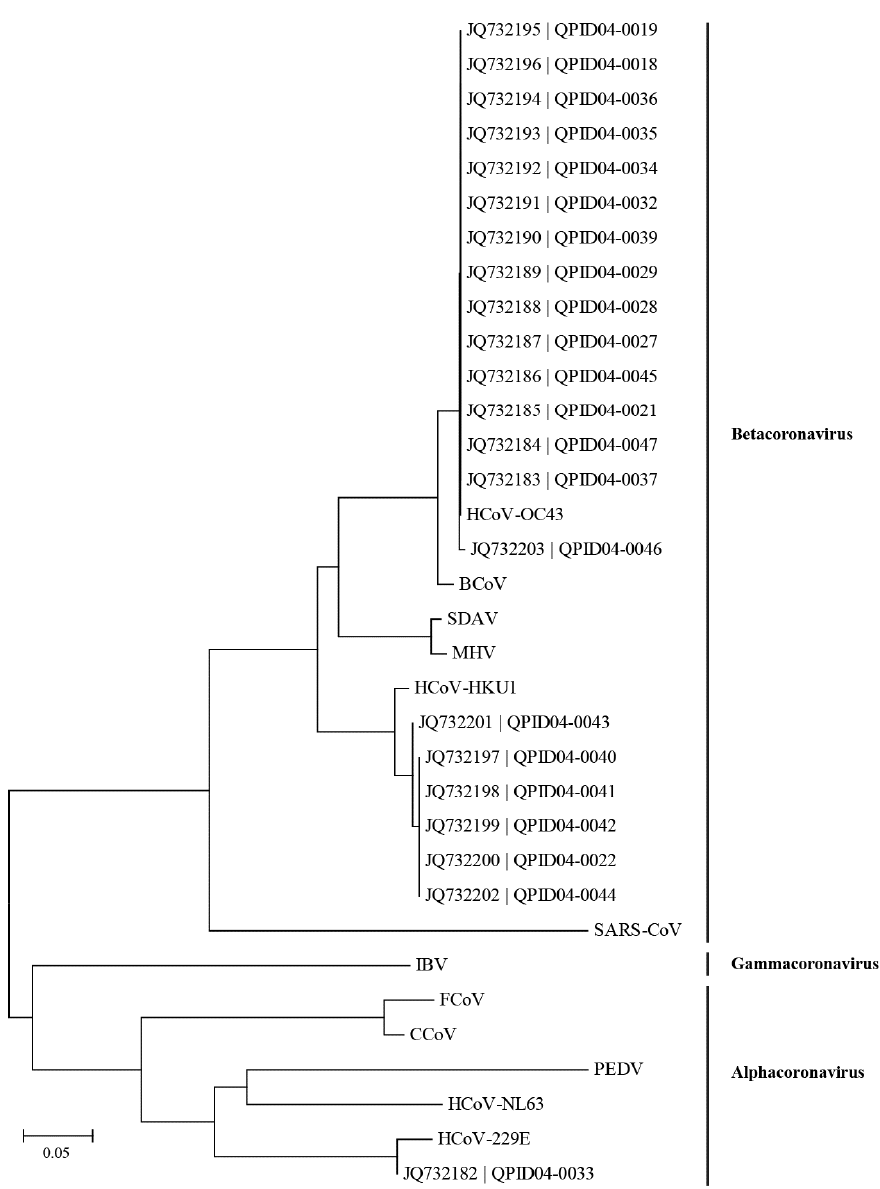
Figure 4. Confirmation of HCoV Identities. Phylogenetic analysis of some Queensland HCoVs detected during the winter of 2004 from cases of ARI, presented on a topology tree prepared in MEGA 5 and compared to other coronavirus sequences (BCoV, DQ811784- bovine coronavirus, assigned ot the same species as HCoV-OC43; PEDV, NC_003436- porcine epidemic diarrhoea virus; MHV, NC_001846-murine coronavirus; CCoV, AF124986-canine coronavirus; FCoV, AF124987-feline coronavirus; IBV, NC_001451- avian infectious bronchitis virus; SDAV, AF124990-; HCoV-NL63, AY567487; HCoV- 229E, AF304460; HCoV-OC43, NC_005147; HCoV-HKU1, NC_006577; SARS-CoV, AY274119). The nucleotide alignment of 225nt of the polymerase gene was prepared using Geneious Pro v5.5. The tree was drawn to scale and evolutionary distances were calculated using the Maximum Composite Likelihood method. HCoV groupings are